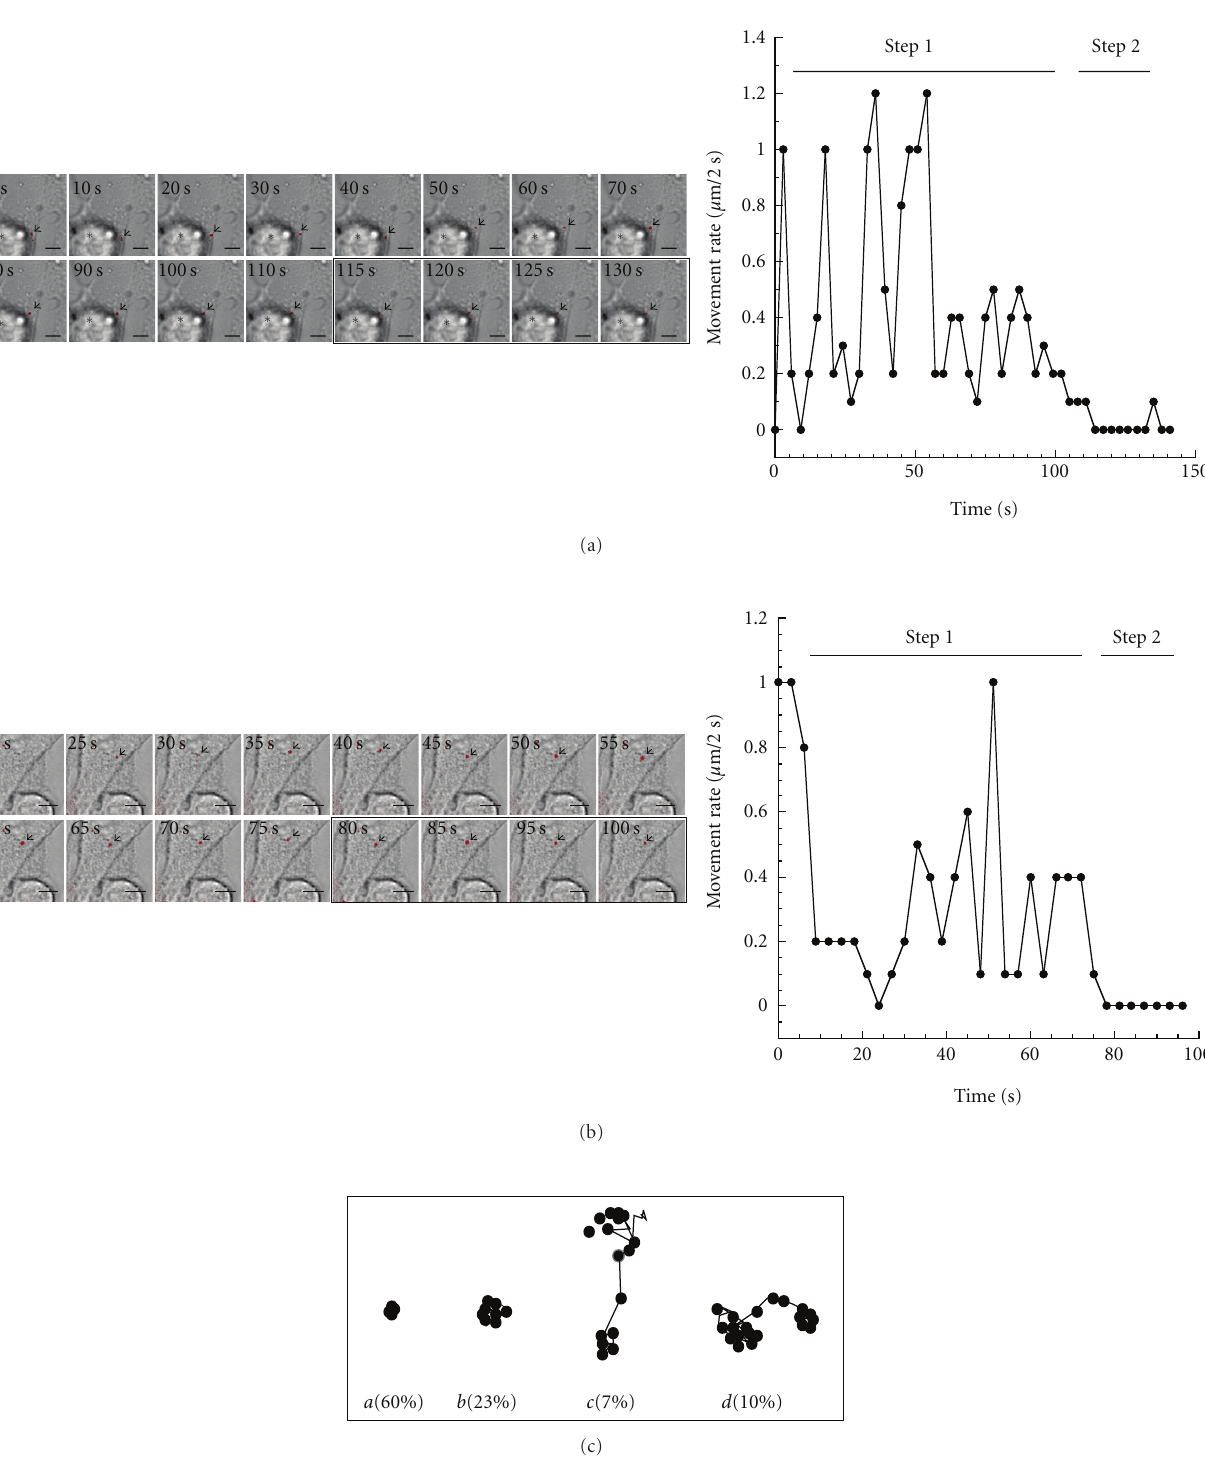
Figure 2: Single-particle tracking of a SINV virus binding to cell surface. Pseudocolor images showing that SINV attachment involved a two-step binding process. (a) A SINV-C (cid:3) -YFP (arrow) was tracked under TIRF mode for 130 seconds. Its movement rate was measured manually frame-by-frame. Boxed images indicate no measurable movement by the virus. (b) Tracking of a SINV labeled with Qdot 605. (c) Four types of representative trajectories of Qdot-labeled SINV movement in BHK plasma membranes. a : immobile; b : mobile but confined in small areas ( < 0.5 µ m diameter); c : mobile through long distances ( > 1 µ m); d : mobile through medium distances (0.5–1 µ m). Scale bar = 10 µ